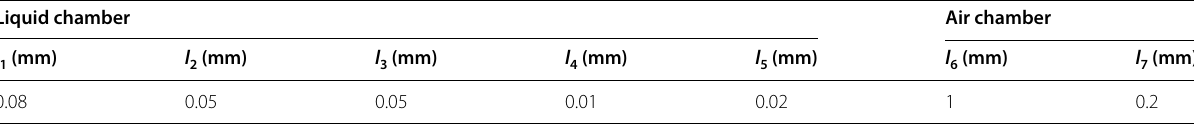
Table 1 Feature size of simulation